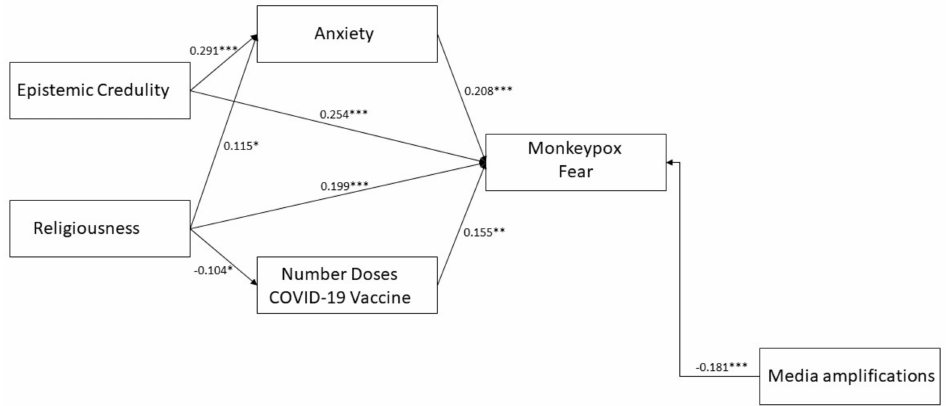
Figure 1. Path diagram partial mediation model of epistemic credulity and religiousness on